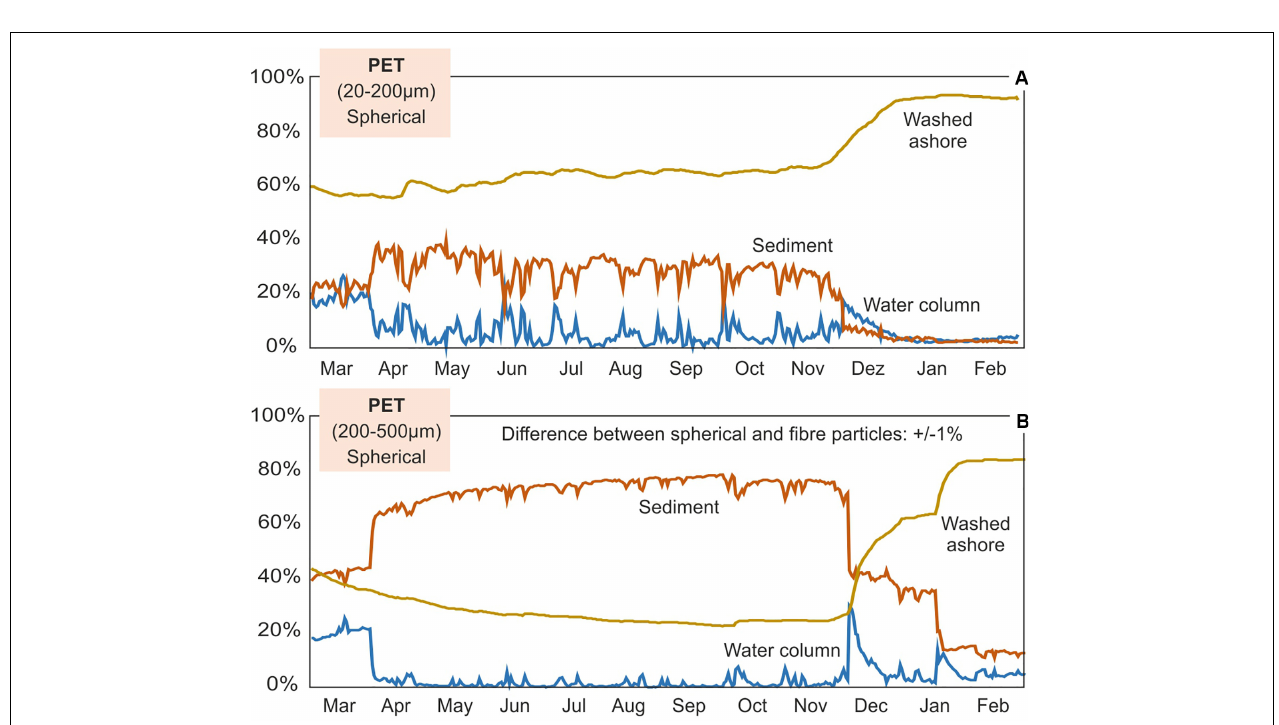
FIGURE 4 | Relative shares of emitted Polyethylenterephthalat (PET) microplastic particles in the water column, on the sediment surface and washed ashore during the course of a year. The results are based on simulations with a 3D hydrodynamic model using meteorological data of the years 2016/2017. The emissions cover all three urban sources and spherical particles of the size fractions (A) 20–500 µ m and (B) 200–500 µ m.